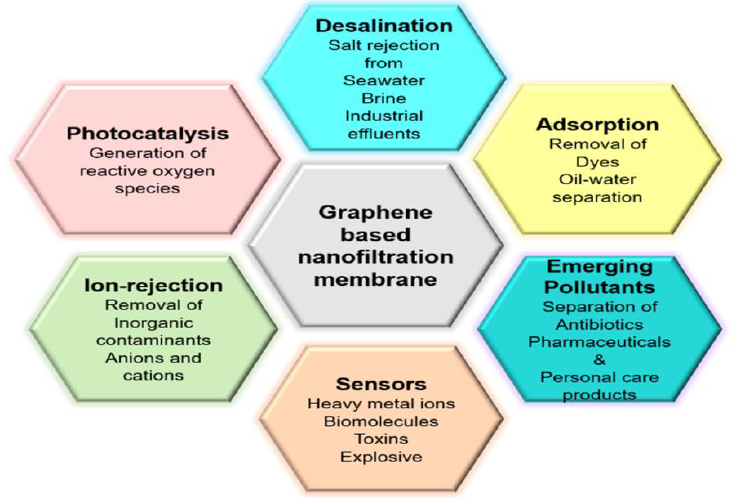
Figure 3. A schematic depiction of the range of water purification applications of the studied mem- branes. Reprinted with permission from Ref. [10]. membranes. Reprinted with permission from Ref.